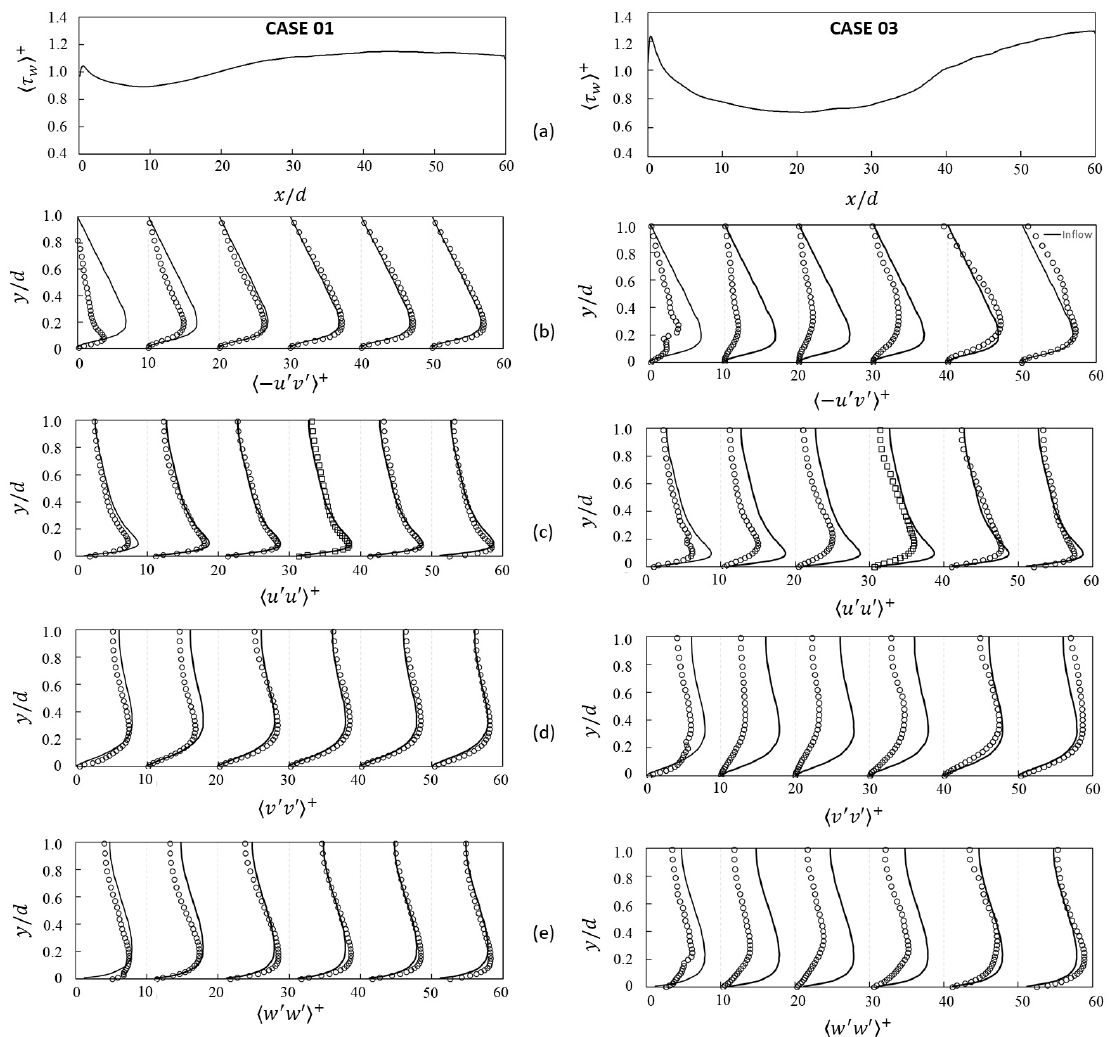
Figure 10. Development of dimensionless wall shear stress and axial stresses. In the figure, at the left: Case 01, at the right: Case 03, solid line: DNS data, ◦ : simulation results. ( a ) wall shear stress, ( b ) Reynolds shear stress, ( c ) streamwise shear stress, ( d ) transverse shear stress, and ( e ) vertical shear